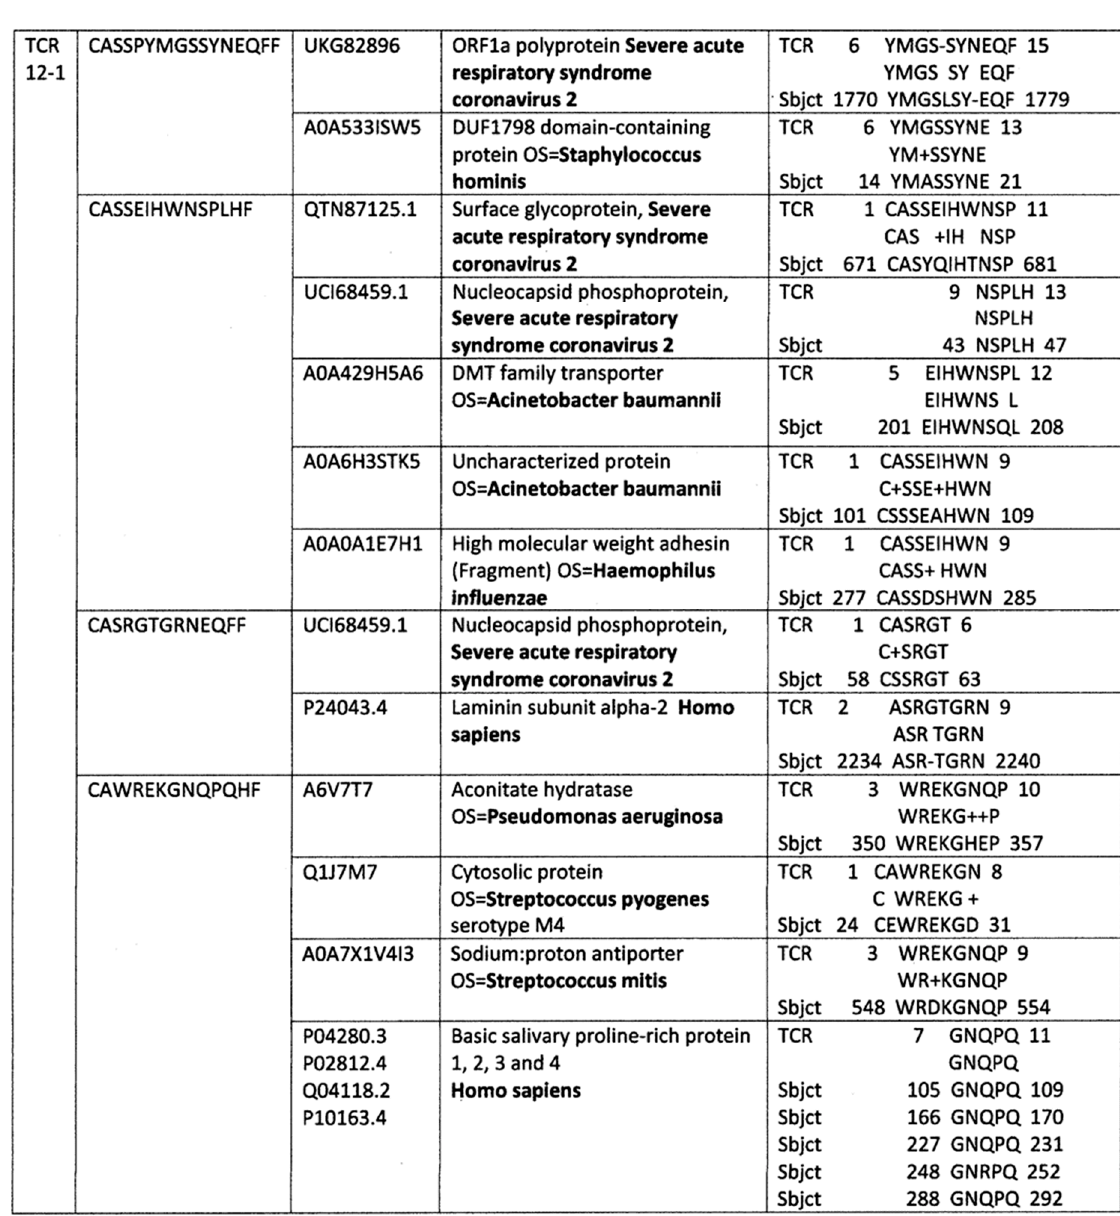
Figure 4. TCR sequences from patient 12-1 [74] and their similarities to viral, bacterial and human proteins found by BLAST. Not only does each TCR sequence mimic a virus, bacterium and/or human protein, the figure also illustrates that many of these viral, bacterial and human proteins mimic each other. Additionally, the specific human proteins identified by this analysis correspond with well-known targets of autoimmune processes associated with COVID-19 including cardiomyopathies (laminin) and anosmia/dysgeusia (basic salivary proline-rich protein). Additional individualized analyses can be found in Appendix A. Numbers in the second column from the left are the UNIPROT identifiers. Species names are in bold for ease of quick identification.